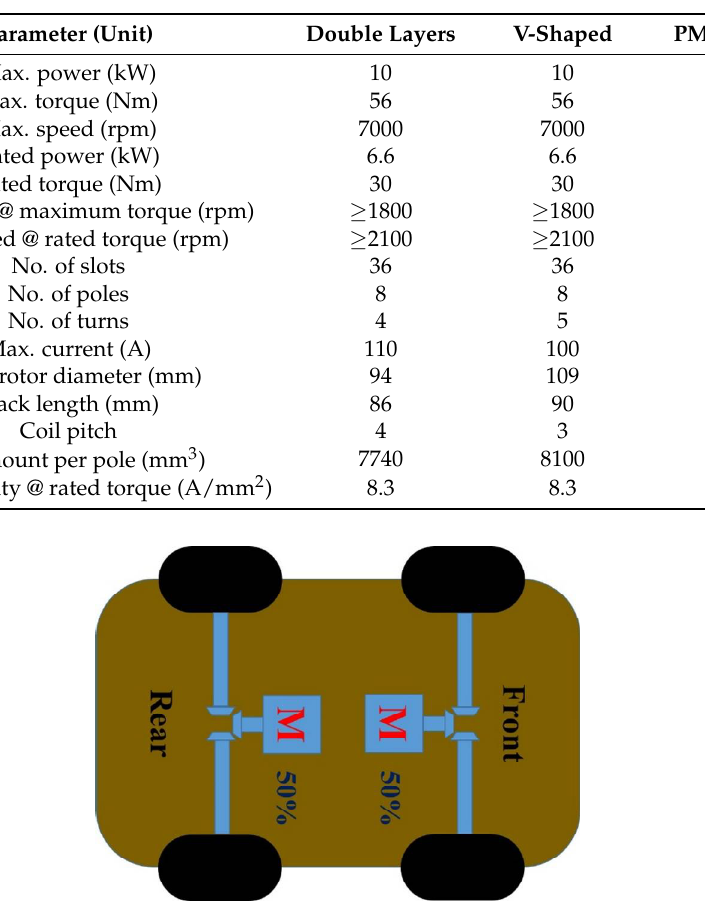
Figure 2. Schematic of a front and rear drives of light-duty vehicle. Table 2. Vehicle